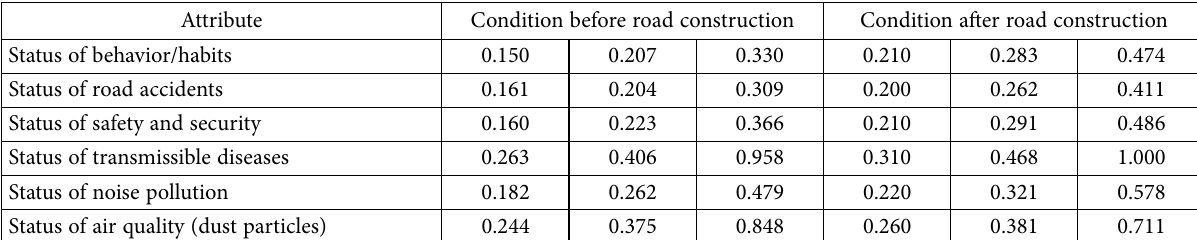
Table 6. Fuzzy ideal and nadir solutions of an attribute with respect to criteria Attribute Condition before road construction Condition after road construction Status of